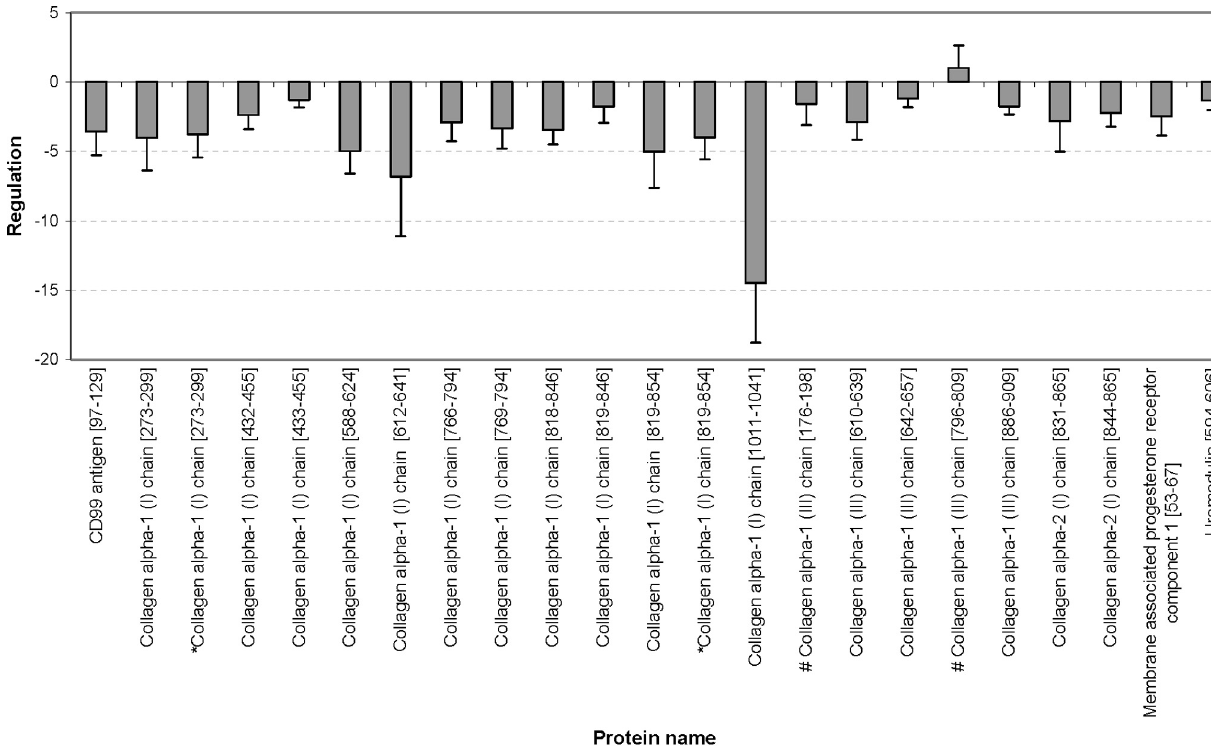
Figure 6. (Down-) Regulation of further peptide markers in urine samples of the PREDICTIONS cohort. Displayed is the regulation of a CD99 antigen fragment, different collagen fragments, membrane associated progesterone receptor component 1 fragment, and uromodulin fragment. The hash ( # ) depicts peptide fragments, which are not significant in this cohort. The asterisk (*) indicate same peptide with one more modification (hydroxylation).